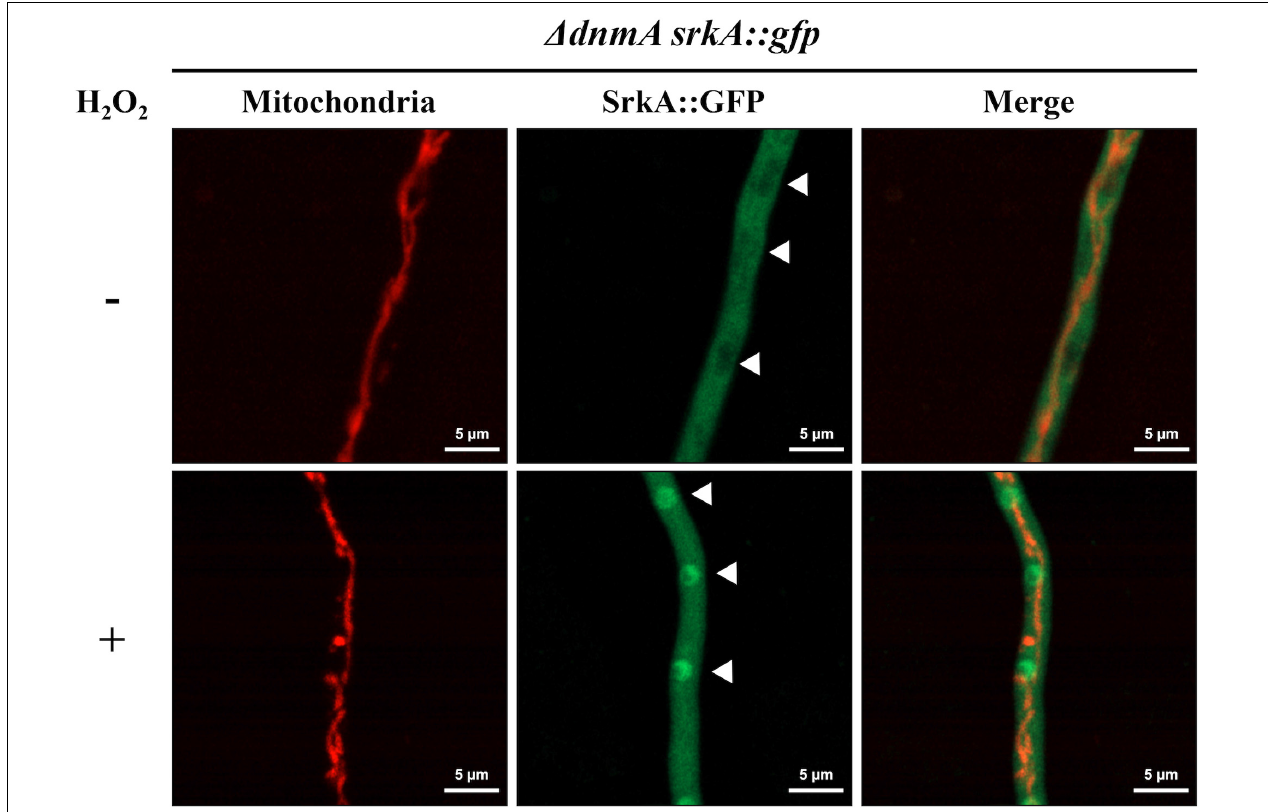
FIGURE 12 | H 2 O 2 induces SrkA nuclear localization in (cid:49) dnmA mutants. Mycelia from strain CVG4 ( (cid:49) dnmA srkA::gfp ) grown for 14 h in supplemented glucose minimal medium was treated or not with 5 mM H 2 O 2 for 20 min and then observed by using confocal microscopy. Arrowheads point to